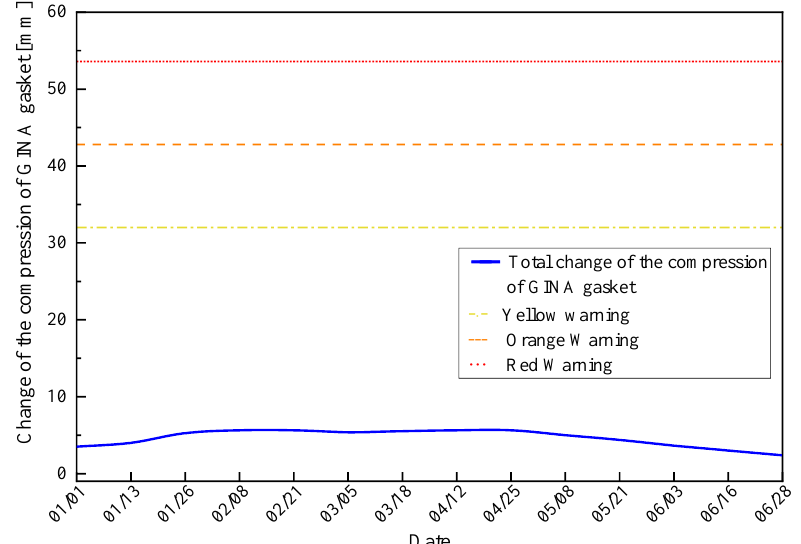
Figure 16. Total change of the compression of GINA gasket between E28 and E29 elements varying with time.